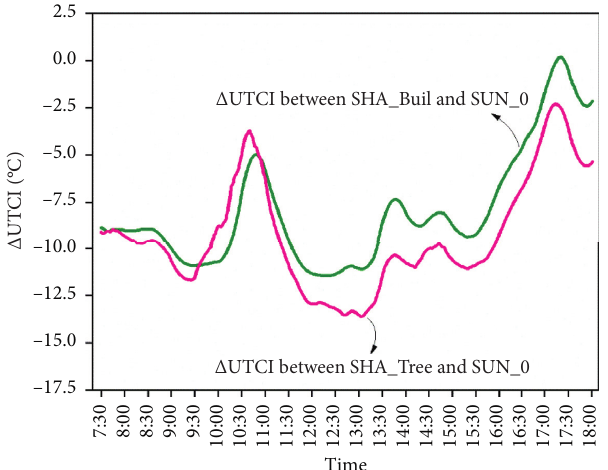
Figure 7: Δ UTCI between the two shaded and the sunlit back- ground meteorological areas on July 29,